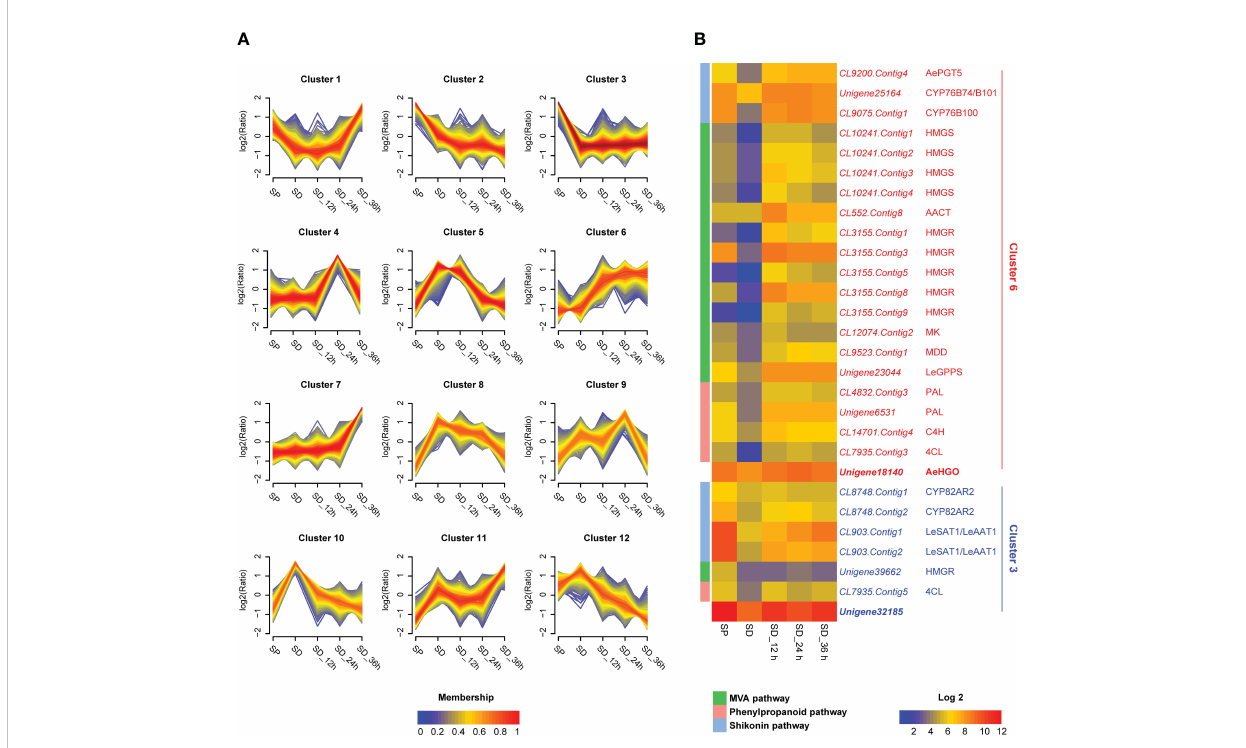
FIGURE 2 Transcriptome analysis of unigenes in SP cell, SD cell, and SD cells in different MeJA elicitation times. (A) Clustering results of the unigenes according to temporal expression patterns in different cell lines (7637 unigenes analyzed). The expression level changes are indicated as log2 fold change. FPKM (Fragments Per Kilobase Million) values were directly used to calculate clustering of unigenes using the fuzzy c-means algorithm Mfuzz (Kumar and Futschik, 2007) with optimal fuzzi fi er “ m ” value and “ min.acore ” value of 0.7. Membership values are color-encoded with red shades denoting high membership values and blue shades denoting low membership values of unigenes. (B) Expression patterns of candidate genes as well as mevalonic acid (MVA), phenylpropanoid, and shikonin pathway genes. The log2 transformed FPKM values are used for preparing the heatmaps. Abbreviations: SP, shikonin-pro fi cient cell line; SD, shikonin-de fi cient cell line; SD_12 h/24 h/36 h, shikonin-de fi cient cell line after treated with MeJA for 12 h/24 h/36 h; AePGT5, A. euchroma para -hydroxybenzoic acid geranyltransferase 5; HMGS, 3-hydroxy-3-methylglutaryl-CoA synthase; AACT, acetoacetyl-CoA thiolase; HMGR, 3-hydroxy-3-methylglutaryl-CoA reductase; MK, mevalonate kinase; MDD, mevalonate diphosphate decarboxylase; LeGPPS, L. erythrorhizon geranyl diphosphate synthase; PAL, L-phenylalanine ammonia lyase; C4H,